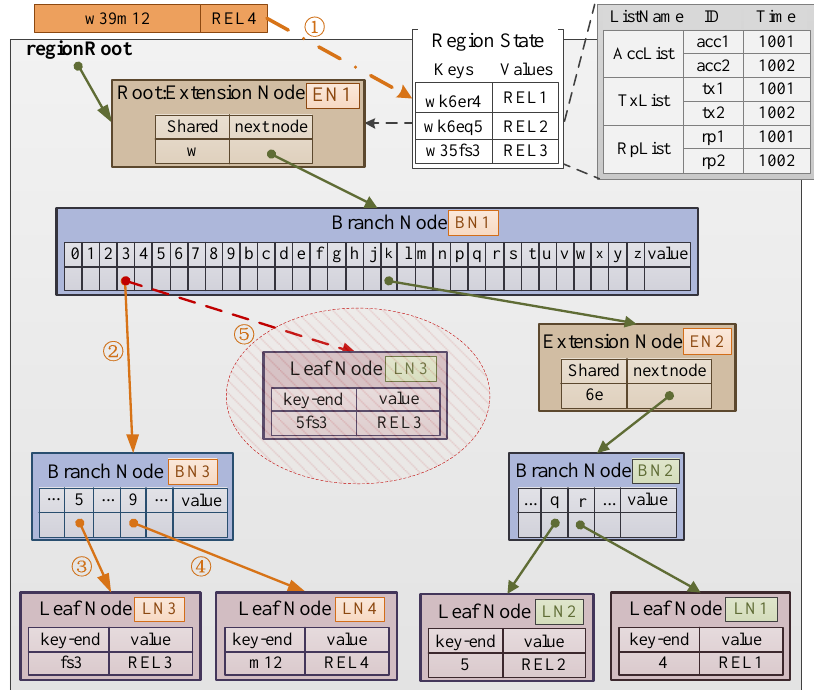
Figure 3. Schematic diagram of the region state trie